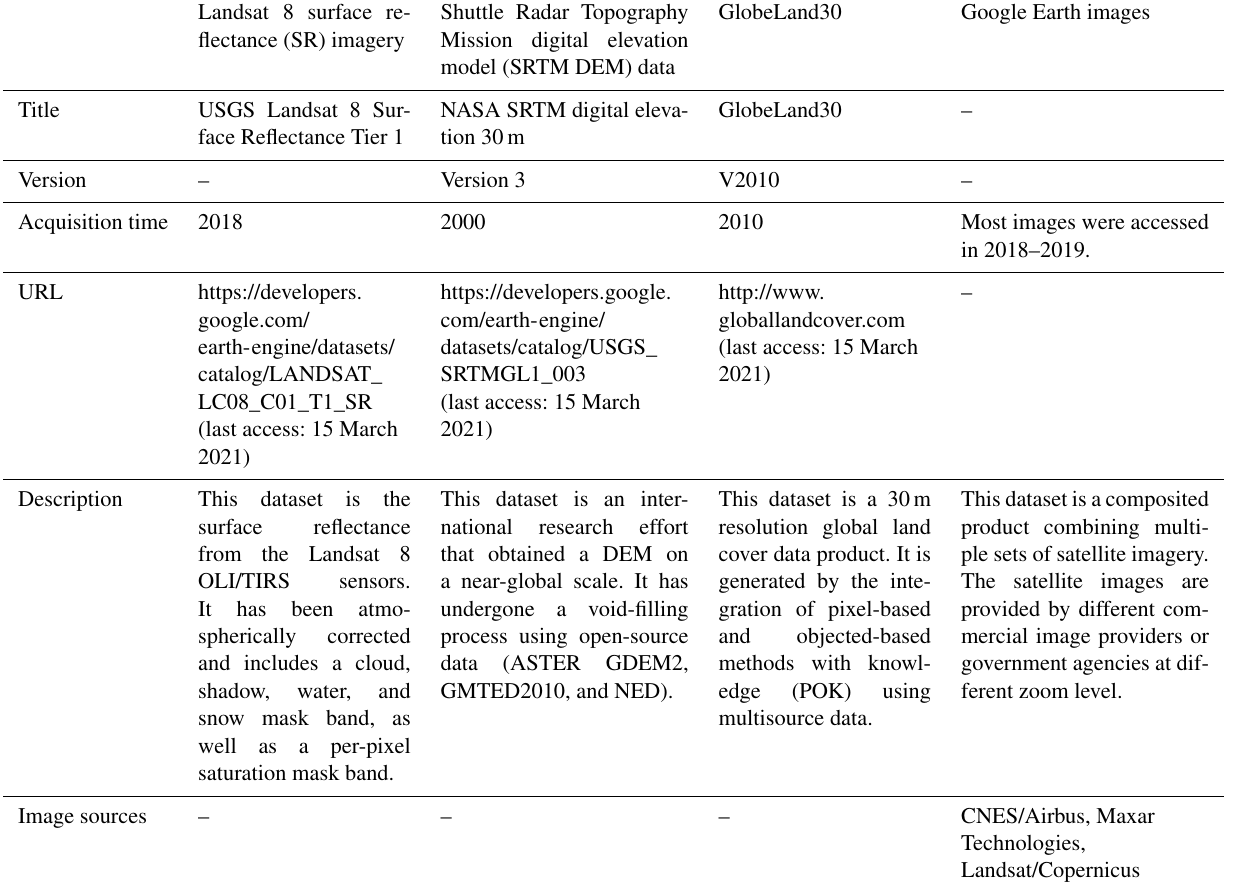
Table 1. Detailed information of data used in this